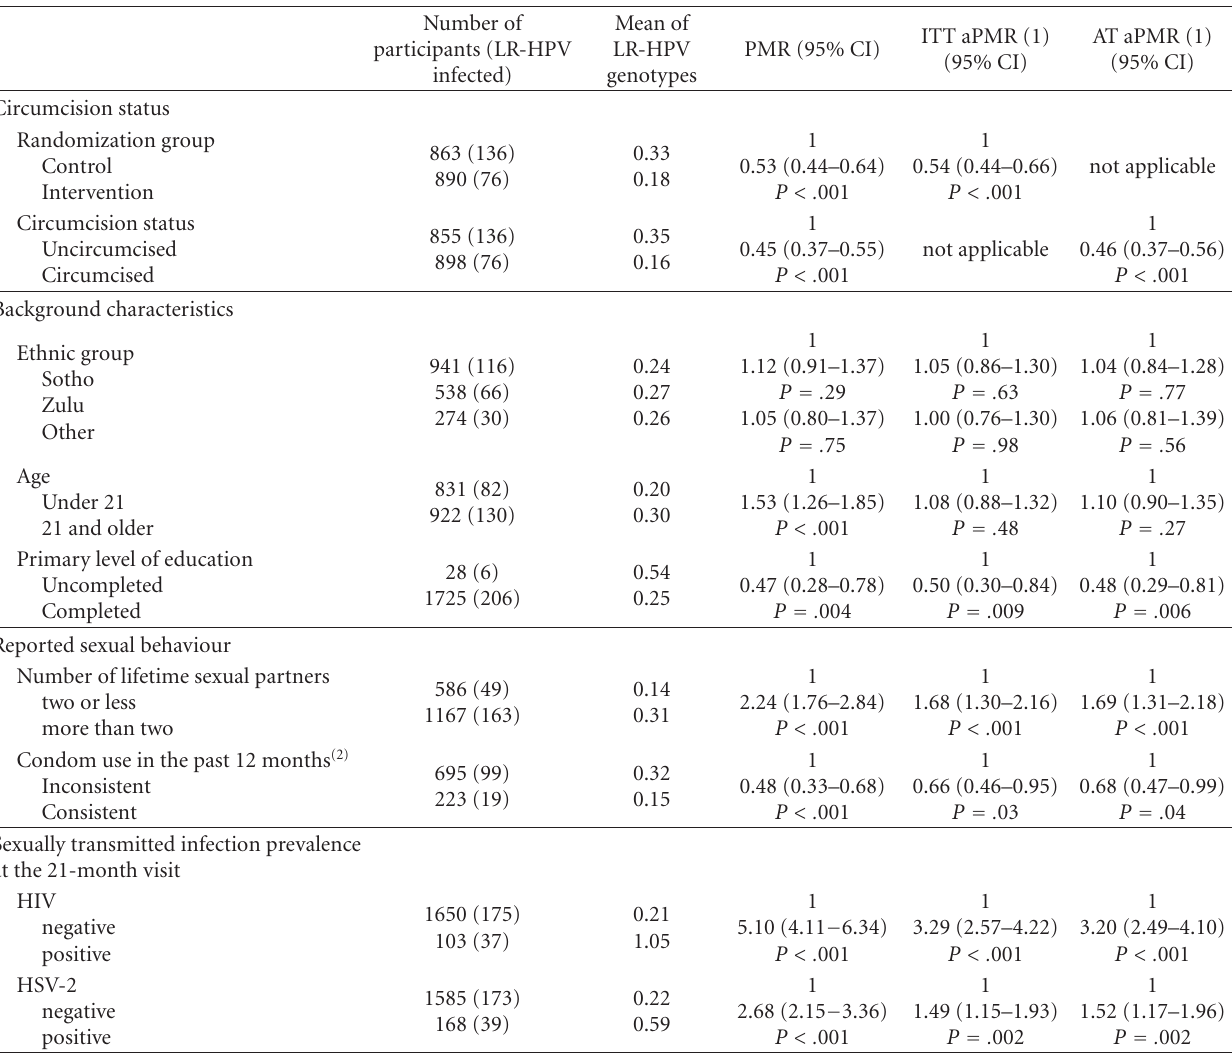
Table 2: Intention-to-treat (ITT) and As-treated (AT) Poisson Mean Ratios (PMRs) of the number of low-risk HPV (LR-HPV) genotypes among the 1753